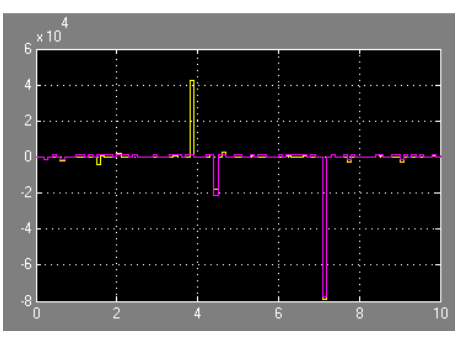
Figure 4. model with using ANN of Scope 3 ‘G 1